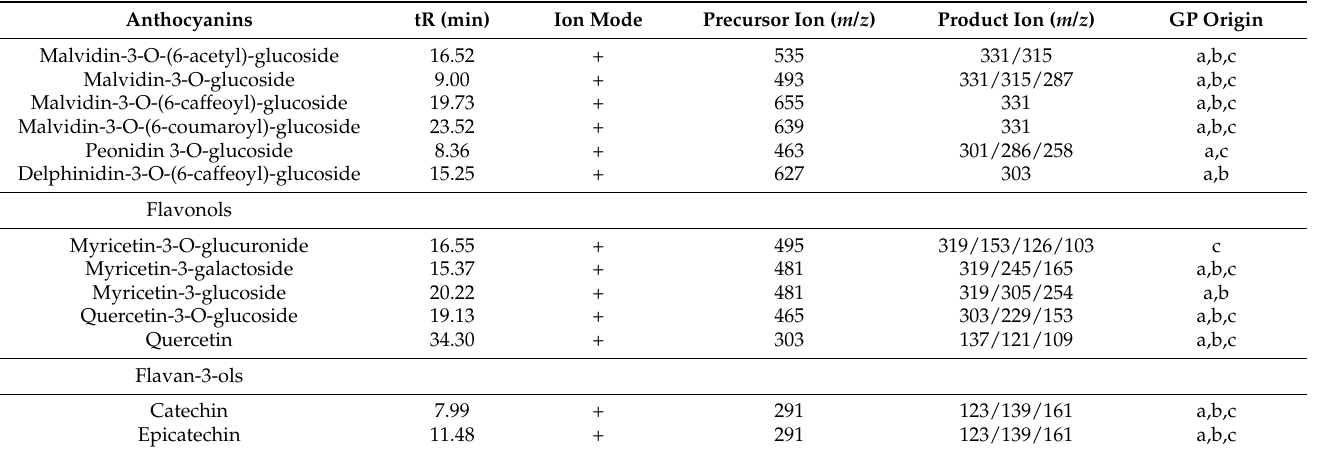
Table 1. Chemical characterization by UHPLC-DAD-ESI-MS/MS of polyphenols in GP extract. GP